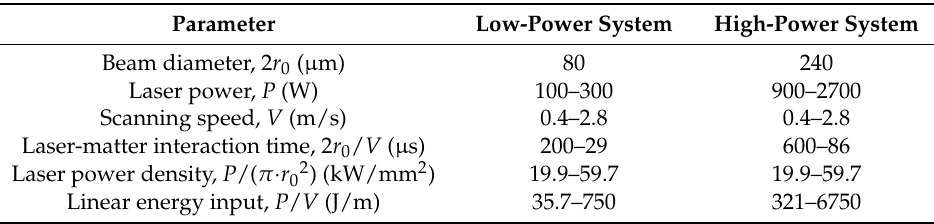
Table 1. Design of